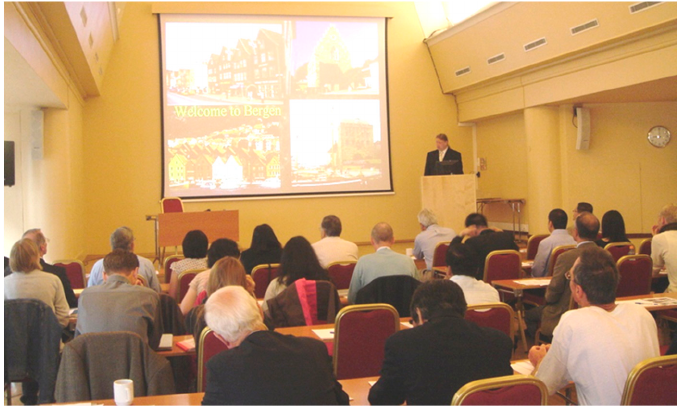
Figure 1. Scene from general session of the sixth Fiery Ice Workshop.